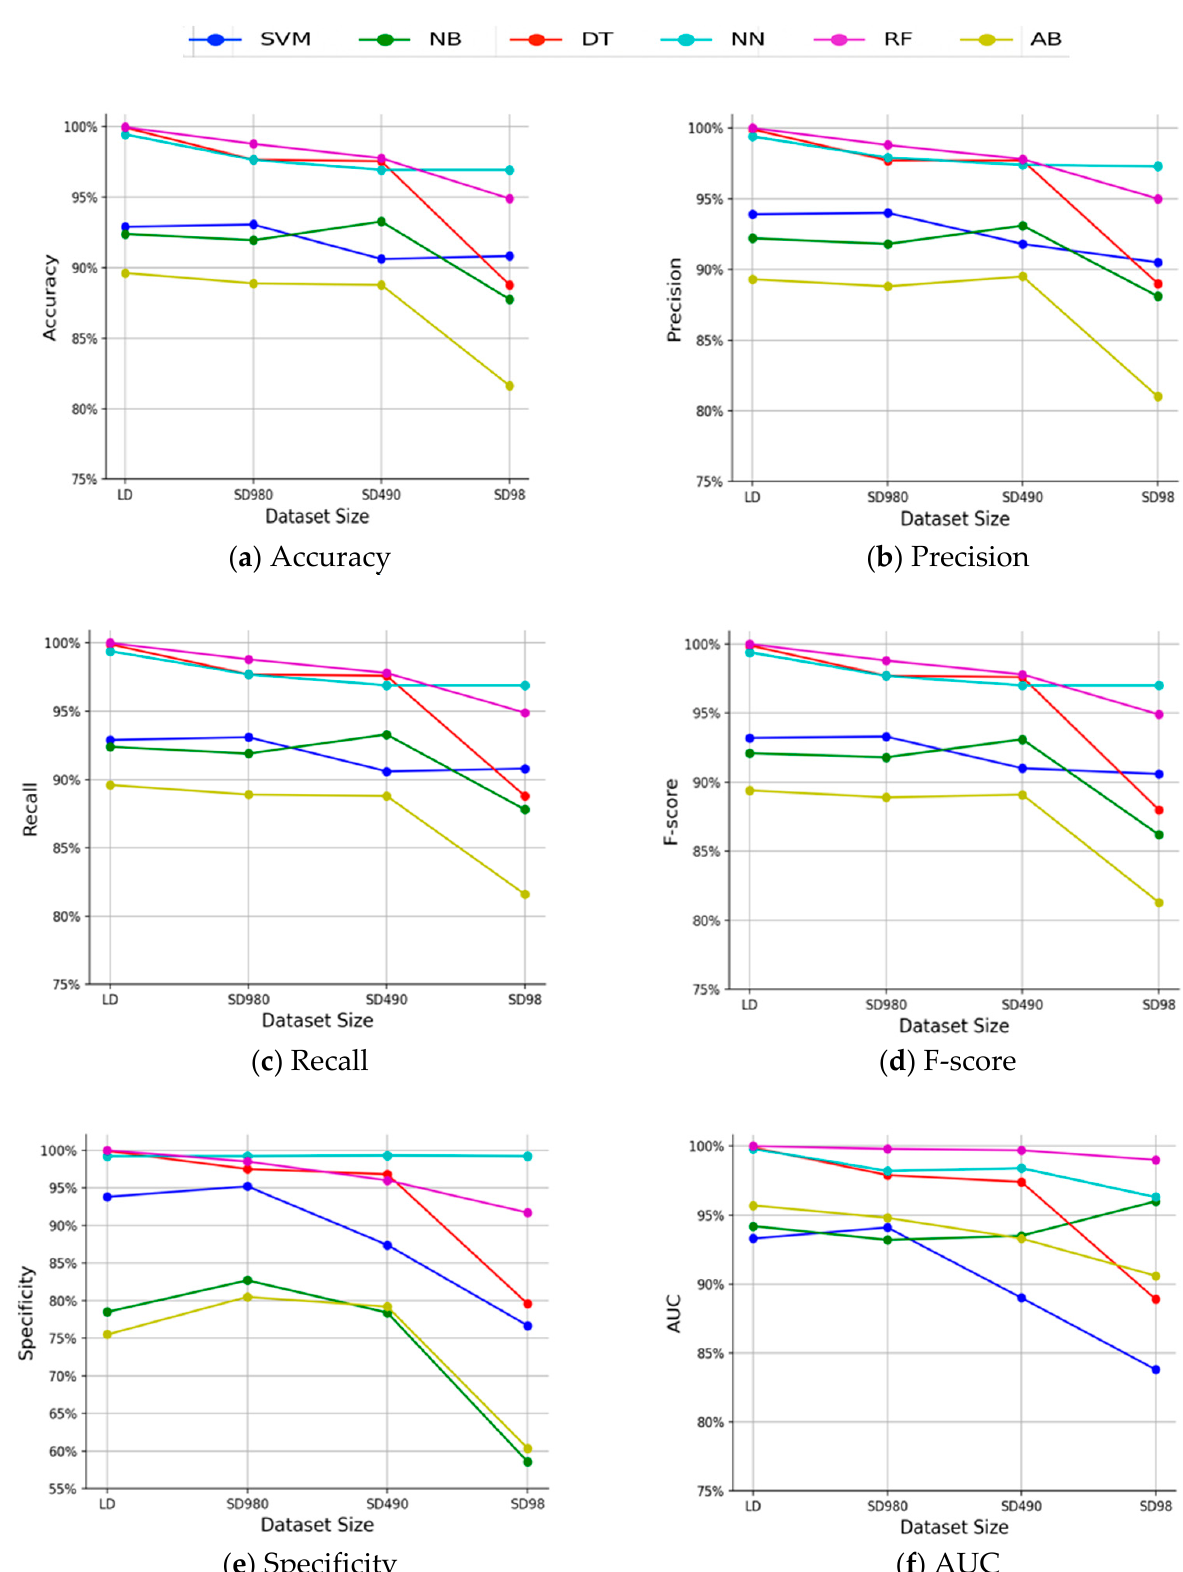
Figure 3. Performance of classifiers with respect to ( a ) accuracy, ( b ) precision, ( c ) recall, ( d ) f-score, ( e ) specificity, ( f ) AUC when trained on skin segmentation dataset and its small subsets.